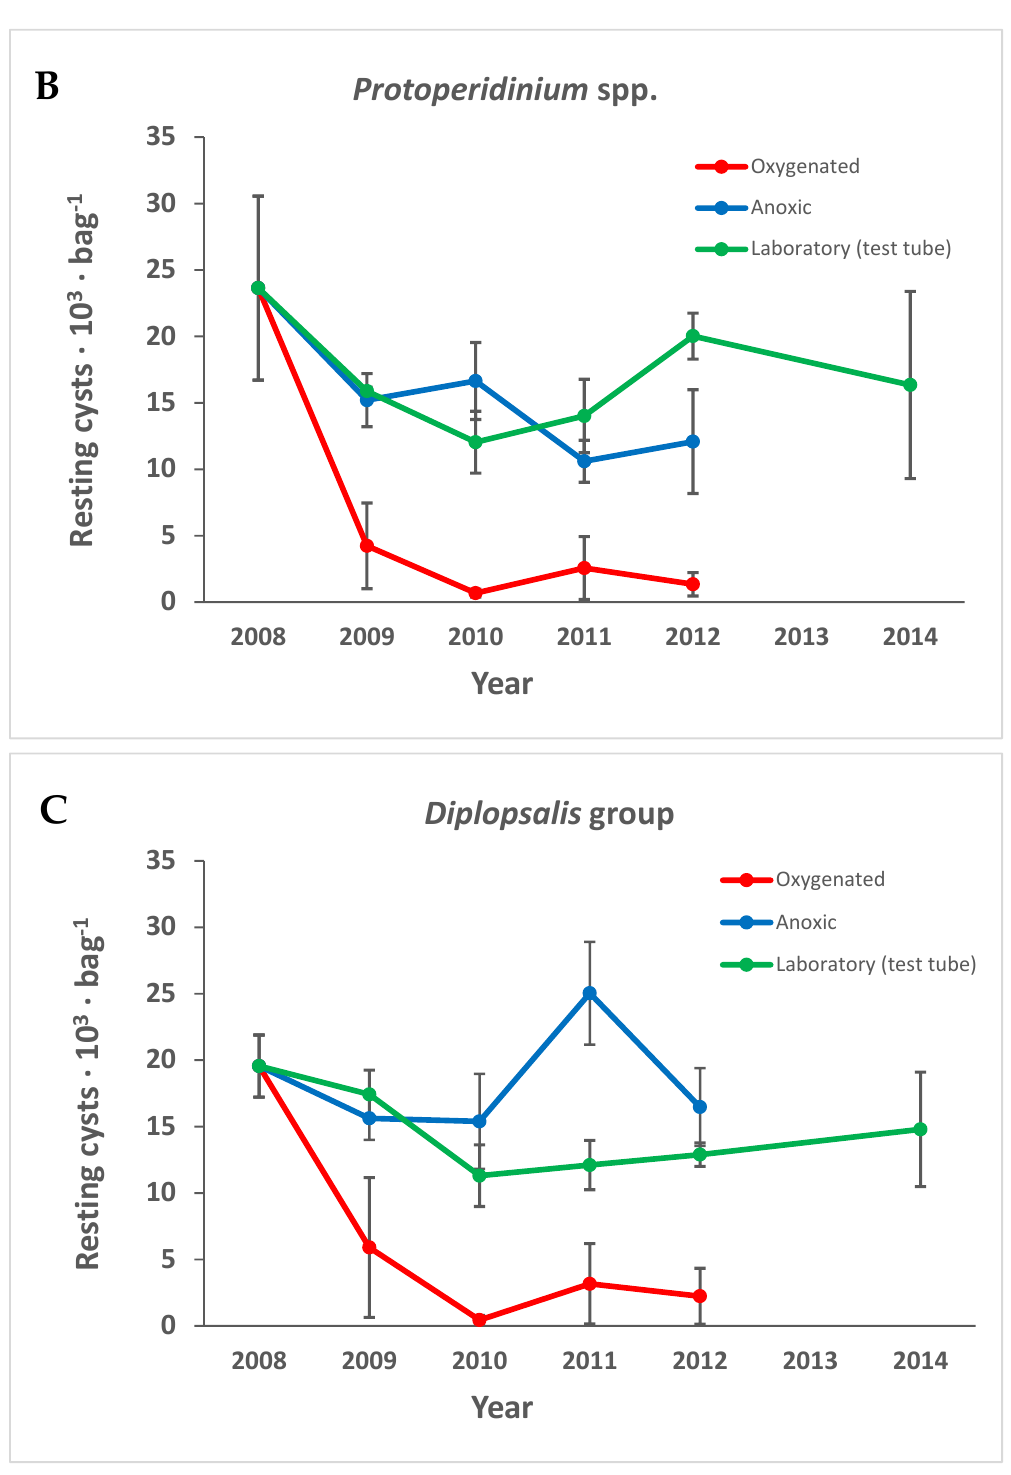
Figure 6. The number of ( A ) Pentapharsodinium dalei , ( B ) Protoperidinium spp., and ( C ) resting cysts of the Diplopsalis gruop over time in the different treatments. Error bars are standard error of the mean.